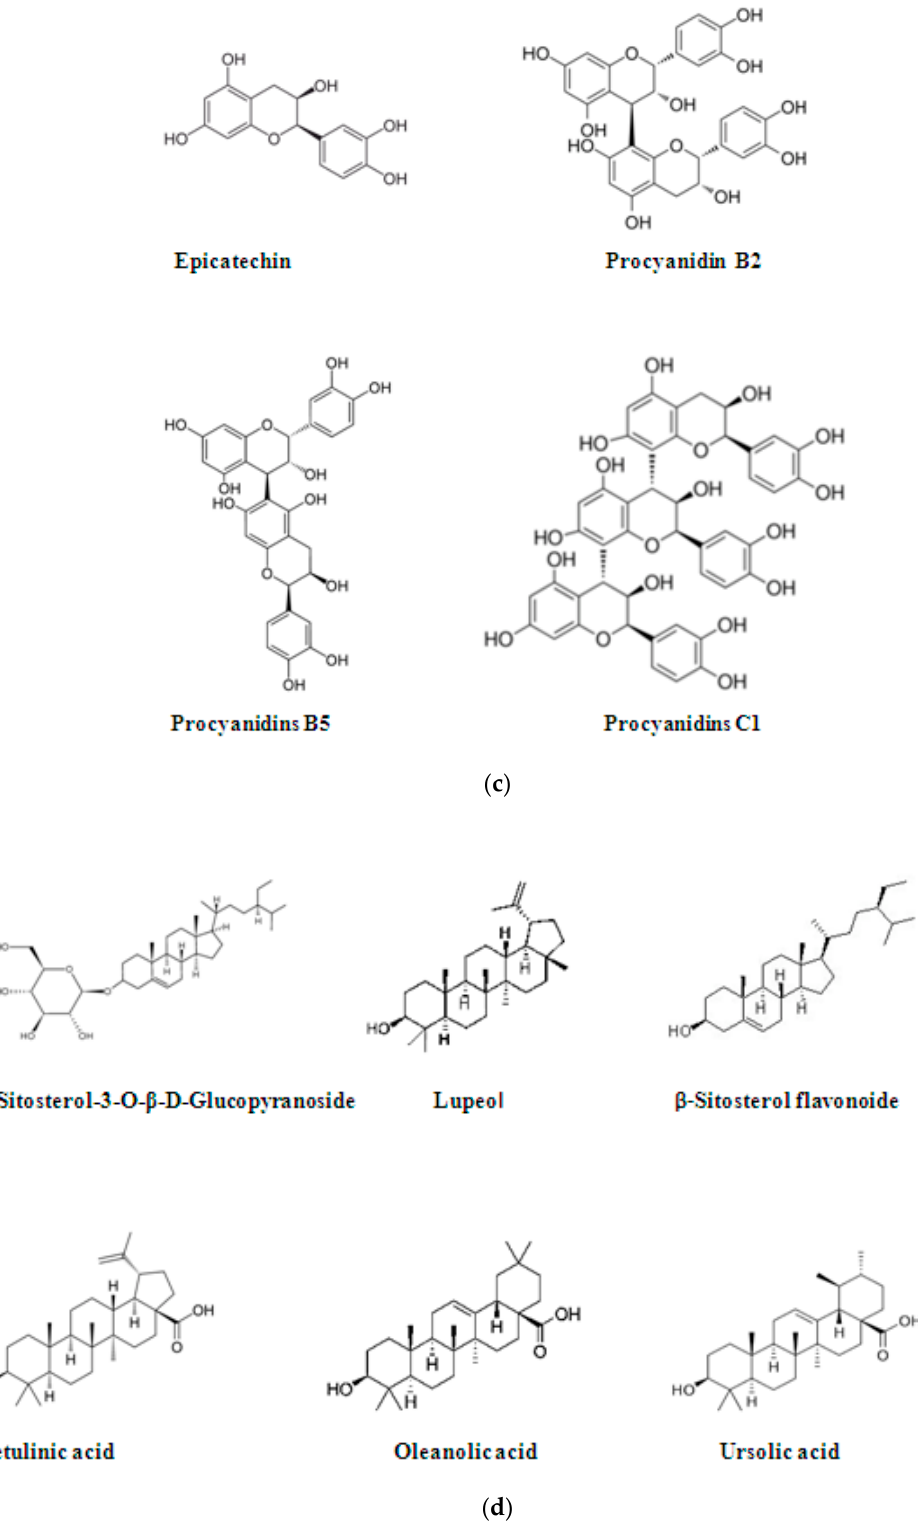
Figure 2. Chemical structure of acids quantified in C. monogyna fruits, plants and flowers. ( a ) Phenolic acids; ( b ) flavonoids and glycosylates derivates in C. monogyna fruits, plants and flowers; ( c ) other flavonoids: epicatechin and procyanidin; ( d ) triterpenoid compounds.